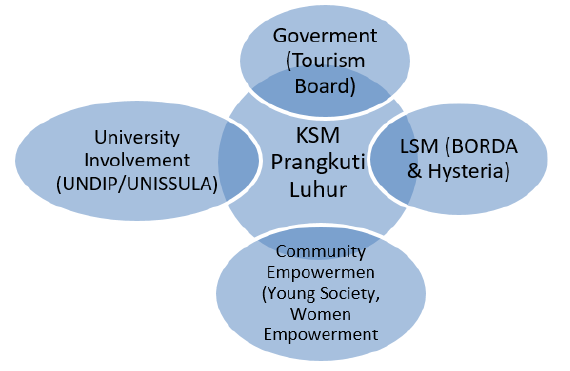
Figure 3. The Networking of Bustaman